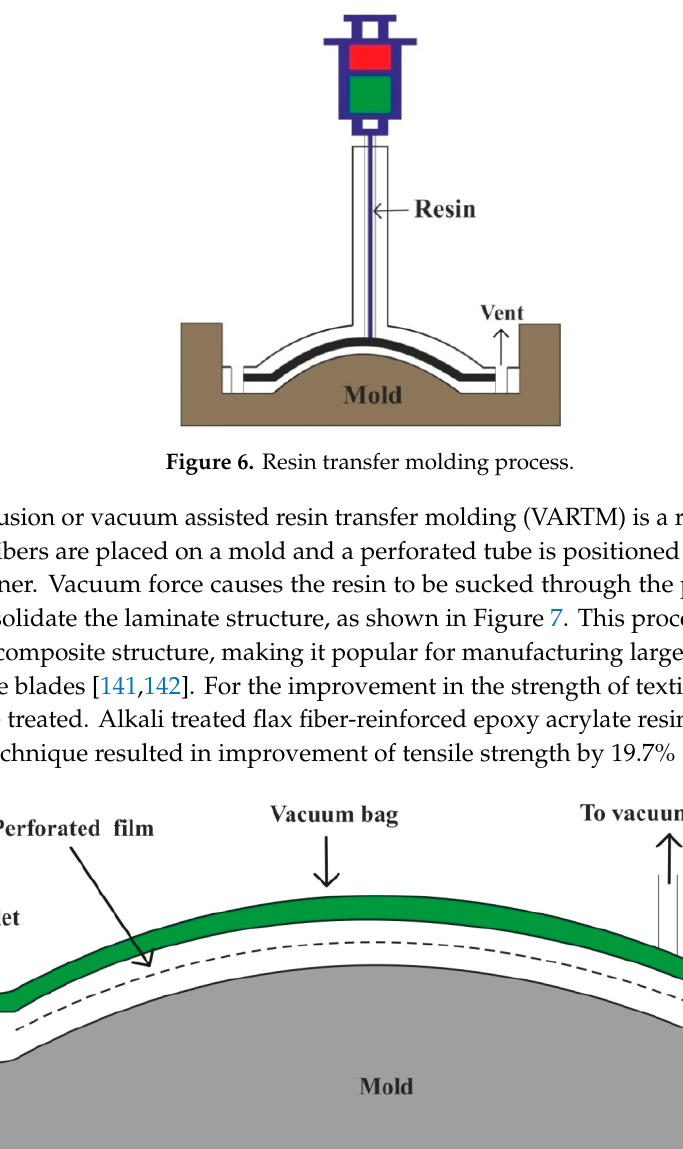
Figure 7. Vacuum infusion process.